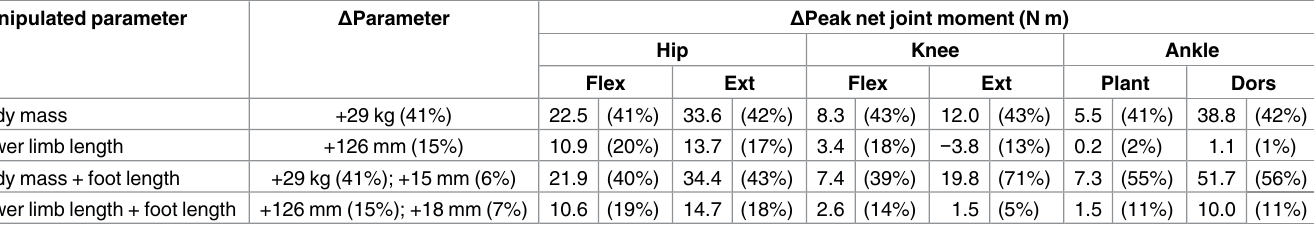
Table 5. Effect of 2 SD increaseof body mass and lower limb length on peak net moments at the hip, knee and ankle evaluated as a change from the mean value in N m and percentages. Manipulated